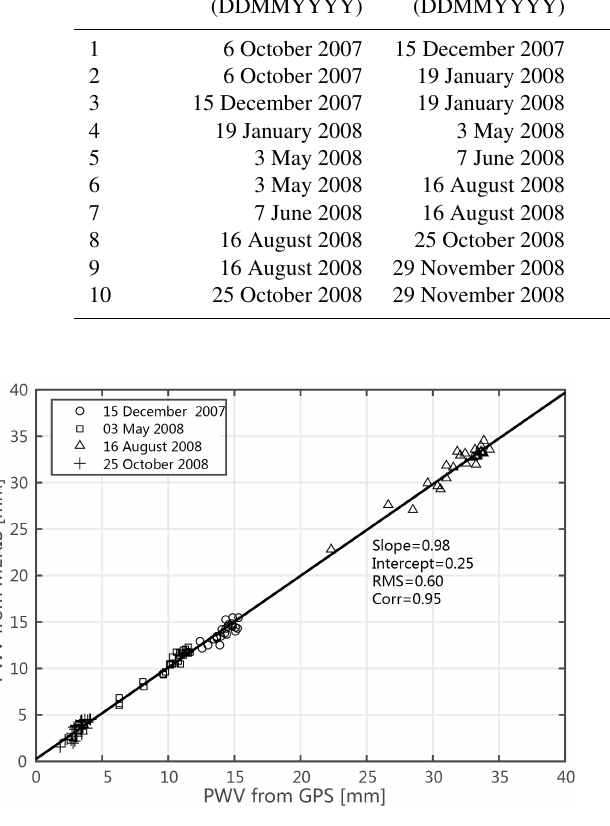
Figure 7. MERIS PWV against GPS PWV at 29 stations on 4 days of ENVISAT overpass time. The MERIS observations are averaged within circles of 5.4km radius centred on the GPS station. Table 2. Constants used for calculating atmospheric delay (Smith and Weintraub,